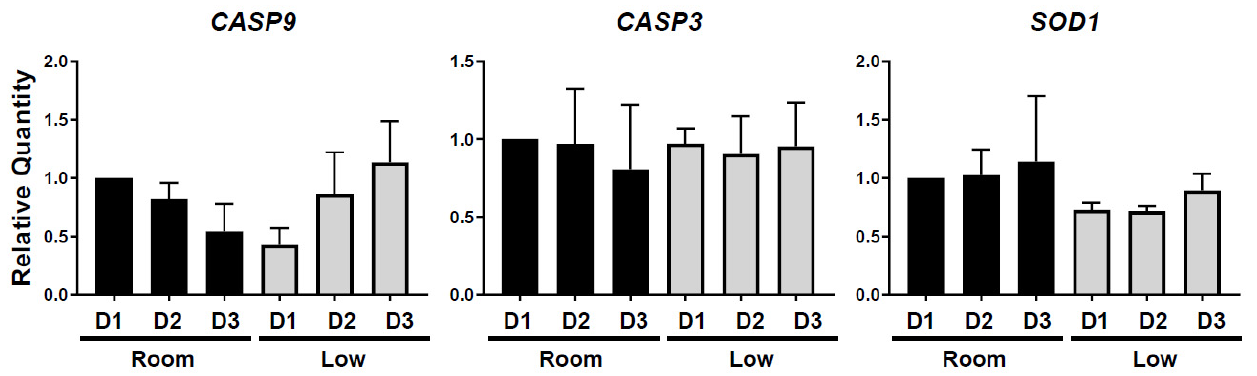
Figure 3. Influence of different storage condition on CASP3 , CASP9 and SOD1 mRNA expressions in hen ovarian tissue. Mean (± SEM) percentages of relative gene expression in different conditions (low temperature, room temperature for 1 to 3 days).